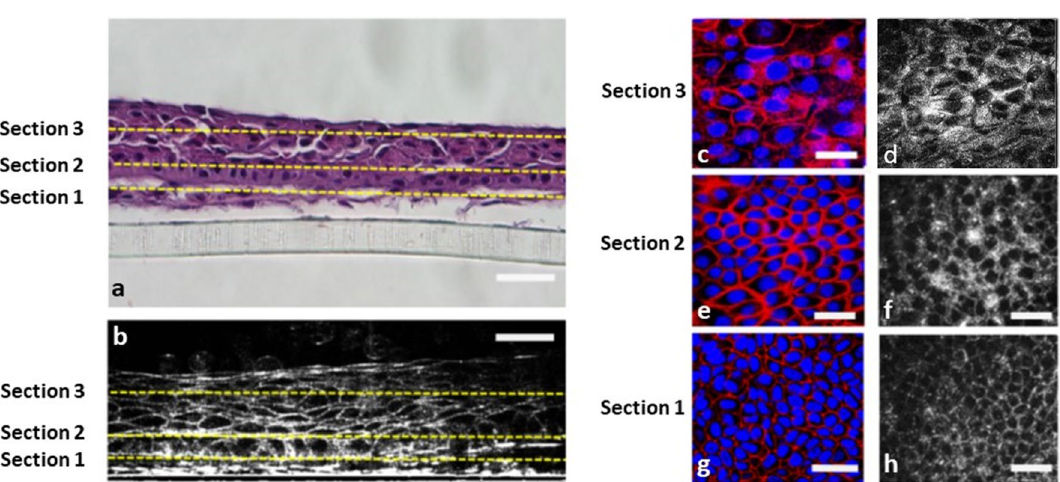
Figure 2. Histological, immunocytochemical, and FF-OCT images of multilayered cultivated cell sheets. ( a ) After the complete culture and formation of mCLESs, haematoxylin and eosin (H&E) staining of the cross- sectional cell product revealed multilayered cell products. ( b ) FF-OCT cross-sectional image of mCLESs. ( a , b ) Sections 1, 2, and 3 represent the basal cell layer at 5 µm, wing cell layer at 20 µm, and superficial squamous epithelial layer at 40 µm above the bottom of the culture plate, respectively. ( c , e , g ) En face images of whole- mount immunocytochemical staining of mCLESs obtained from in vitro confocal microscopy at Section 1 ( g ), Section 2 ( e ), and Section 3 ( c ). Red: Actin. Blue: Hoechst 33,258 for the nucleus. ( d , f , h ) FF-OCT en face images of mCLESs at Section 1 ( h ), Section 2 ( f ) and Section 3 ( d ). Scale bar = 20 µm. mCLESs = multilayer cultivated limbal epithelial